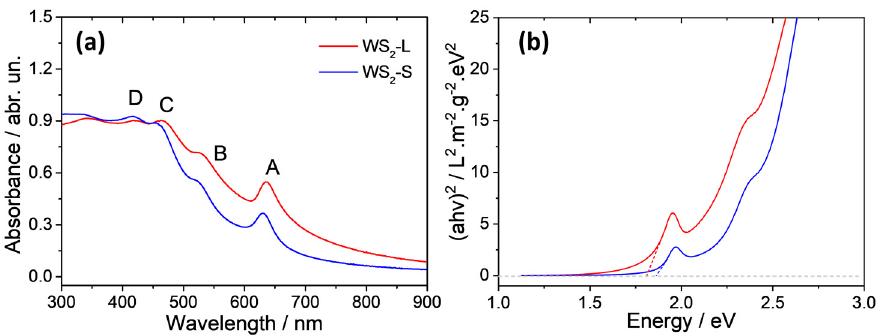
Figure 3. ( a ) UV-Vis absorption spectra and ( b ) Tauc plots of WS 2 nanosheets (WS 2 -L red line, WS 2 -S blue line).